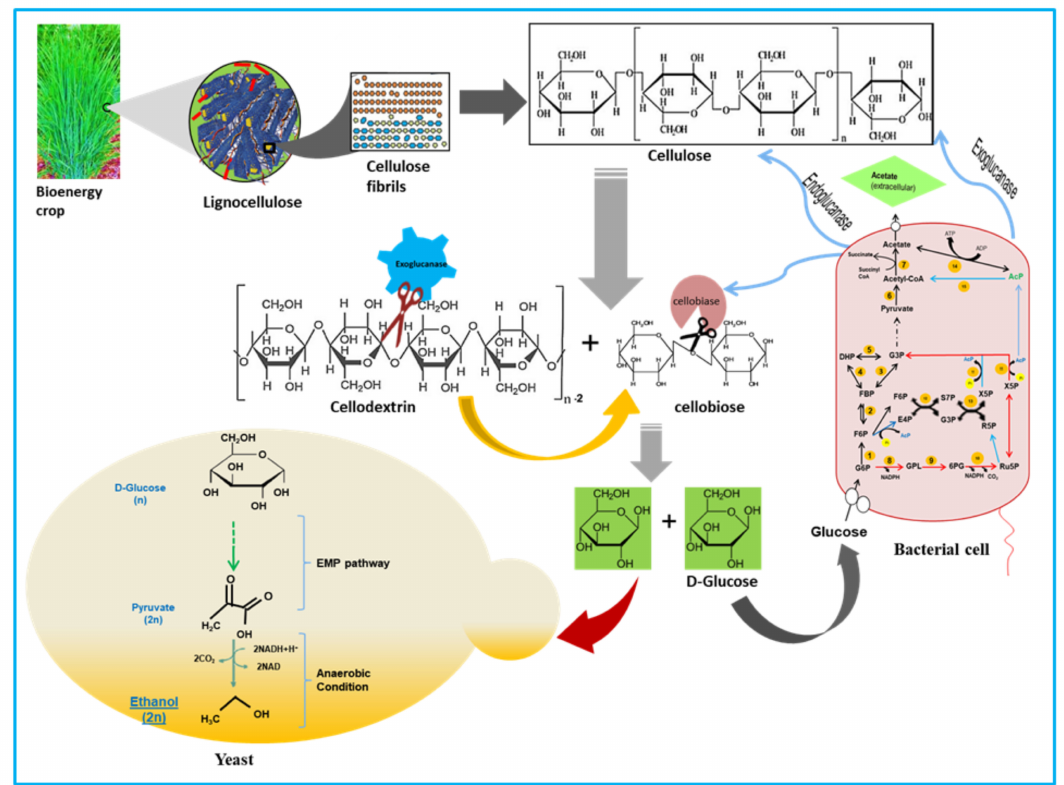
Figure 9. Predicted mechanism/pathways used by B. altitudinis RSP75 for the metabolism of cellulose with syner- gism with yeast strain for ethanol production. G6P: glucose-6-phosphate; GPL: 6-phospho glucono 1, 5 lactone; 6PG: 6-phosphogluconate; Ru5P: riulose-5-phosphate; X5p: xylulose-5-phosphate; R5P: ribose-5-phosphate; S7P: sedoheptulose- 7-phosphate; G3P: glyceraldehyde-3-phosphate; F6P: fructose-6-phosphate; E4P: erythrose-4-phosphate; F6P: fructose-6- phosphate; FBP: fructose-1,6-bisphosphate; DHP: dihydroxyacetone phosphate; AcP: acetyl phosphate. The numbers in yellow circles indicate enzymes, 1: glucokinase; 2: phosphoglucokinase; 3 and 4: aldolase; 5: isomerase; 6: pyruvate dehydro- genase complex; 7: pyruvate oxidase; 8 and 9: glucose-6-phosphate dehydrogenase; 10: 6-phosphogluconate dehydrogenase; 11: bifunctional phosphor ketolase; 12: transaldolase; 13: transketolase; 14: acetate kinase; 15: